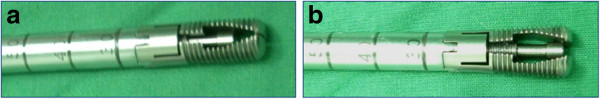
a The I-VEP is in resting status. b The I-VEP is in expanding status.